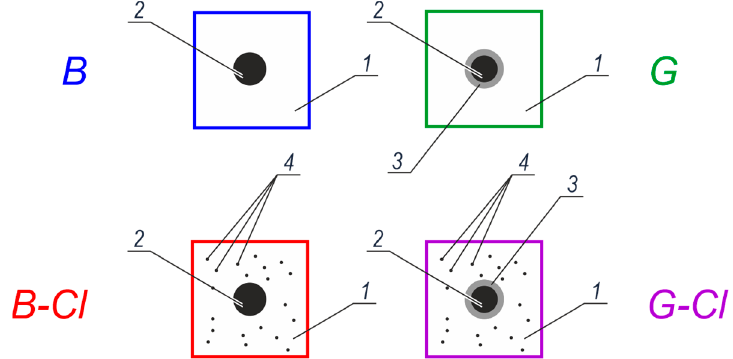
Figure 1. Four groups of reinforced concrete test elements used in tests: 1—concrete without additives, 2—black steel, 3—zinc coating on reinforcing steel, and 4—chlorides in concrete. Assigned symbols and colors are consequently used in this paper to describe and analyze performed